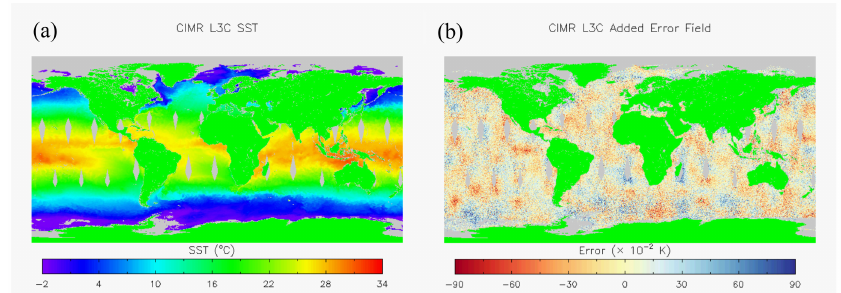
Figure 1. ( a ) Example of the daily sea surface temperature (SST) field from a Copernicus Imaging Microwave Radiometer (CIMR) level 3 collated (L3C) file and ( b ) the added error field for this CIMR L3C field.